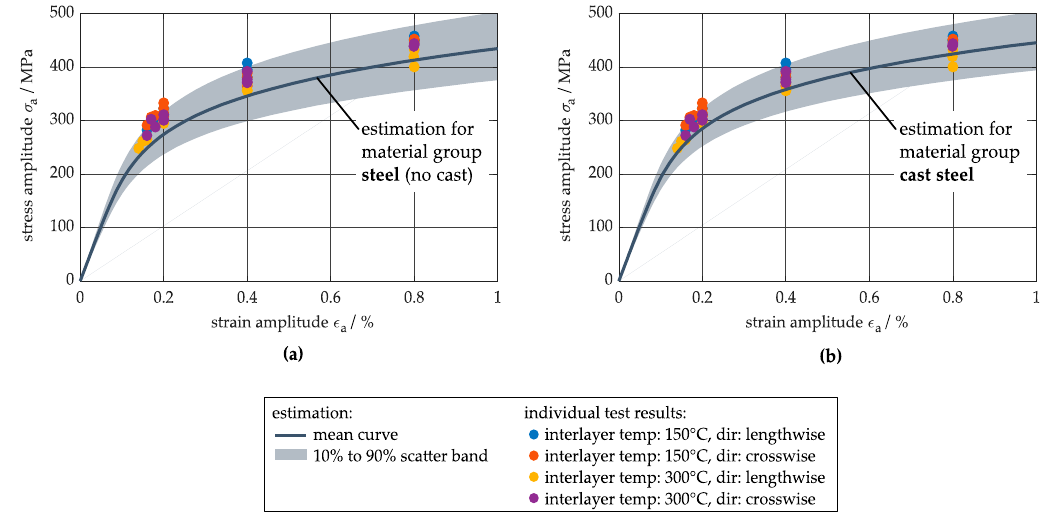
Figure 15. Estimated cyclic stress–strain curves for steel ( a ) and cast steel ( b ) for R m = 538 MPa and individual test results from Figure 11.